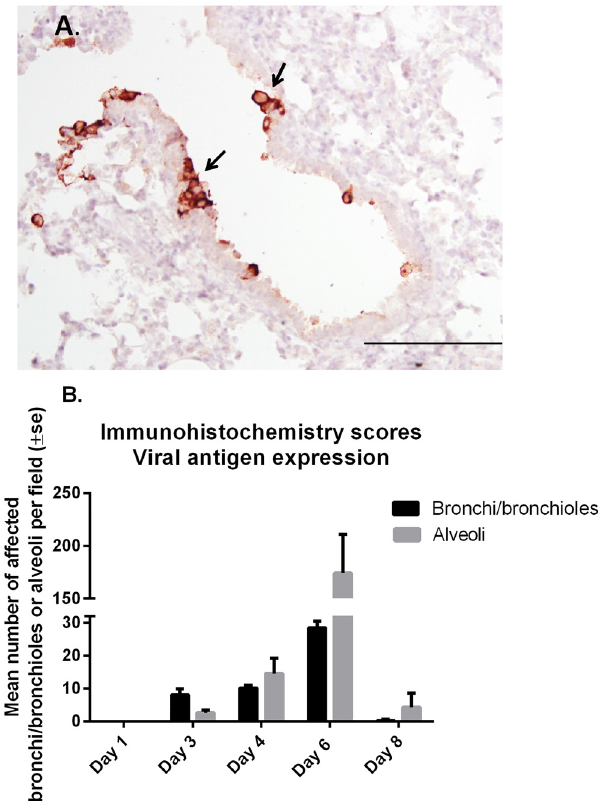
Fig 4. Immunohistochemistry and scoring of RSV antigen expression in lambs inoculated with M37 hRSV. Immunohistochemistry was used to detect viral antigen using an all-antigens polyclonal antibody for RSV. (A) RSV immunoreactivity is shown within epithelial cells lining the bronchioles (brown cells). Bar = 50 μ m (B) The mean number of virally-infected bronchi/bronchioles and alveoli per field was counted for each day of